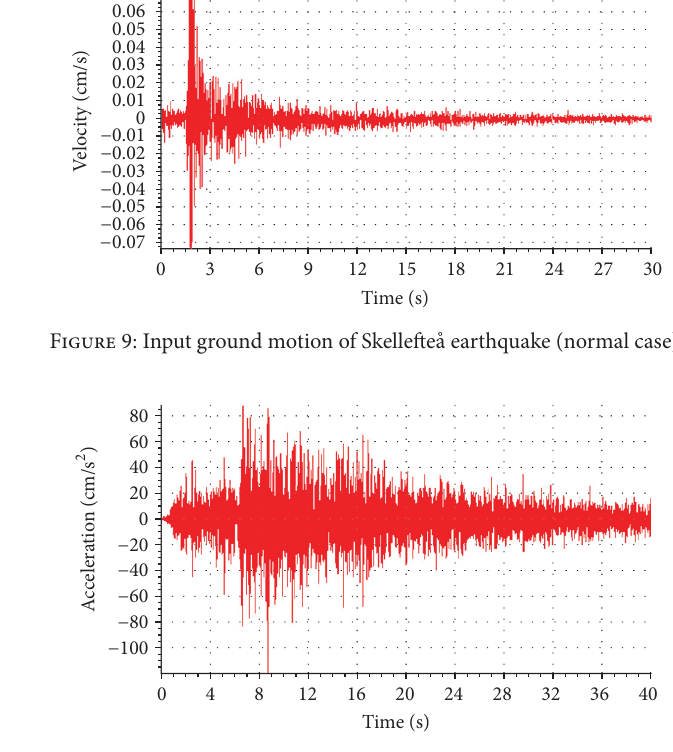
Figure 10: Input ground motion of Virginia earthquake (extreme